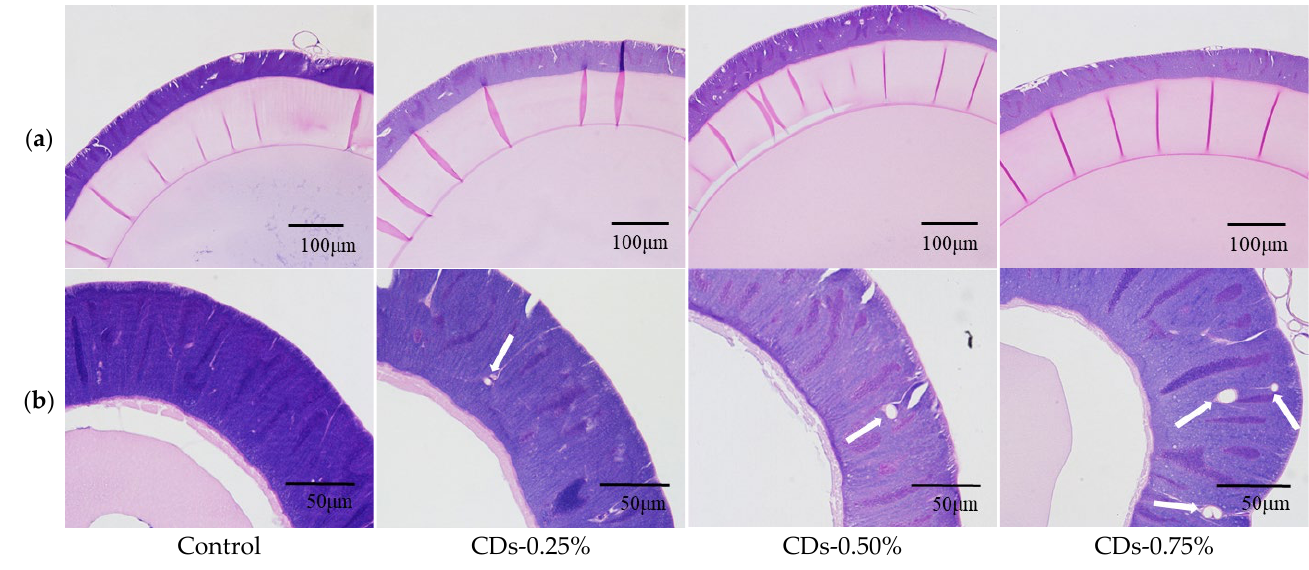
Figure 3. Histophysiological images of silkworms: ( a ) middle silk gland; ( b ) posterior silk gland. The white arrow points to the vacuoles in the posterior silk glands.